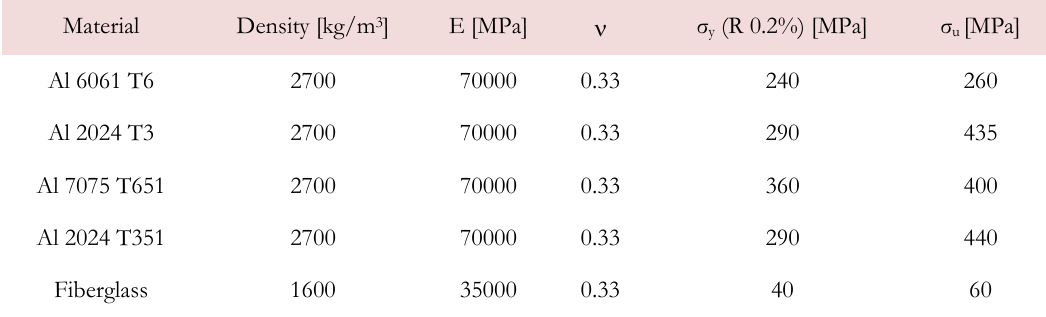
Table 2: Mechanical properties of materials.